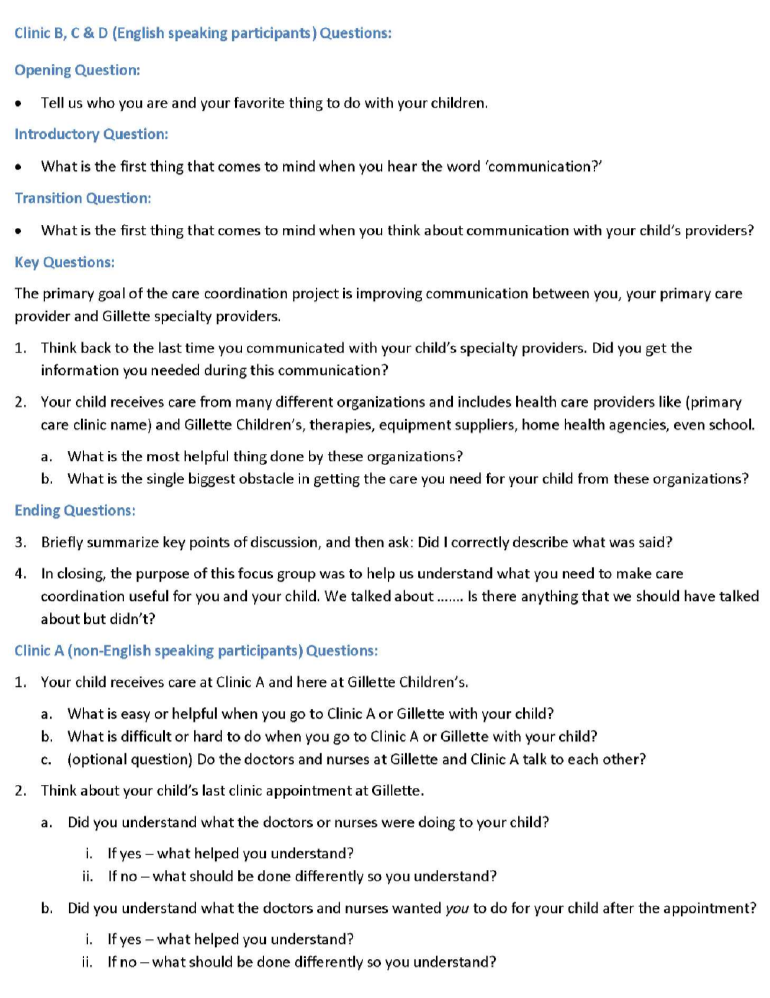
Figure A1. Parent focus group questions.